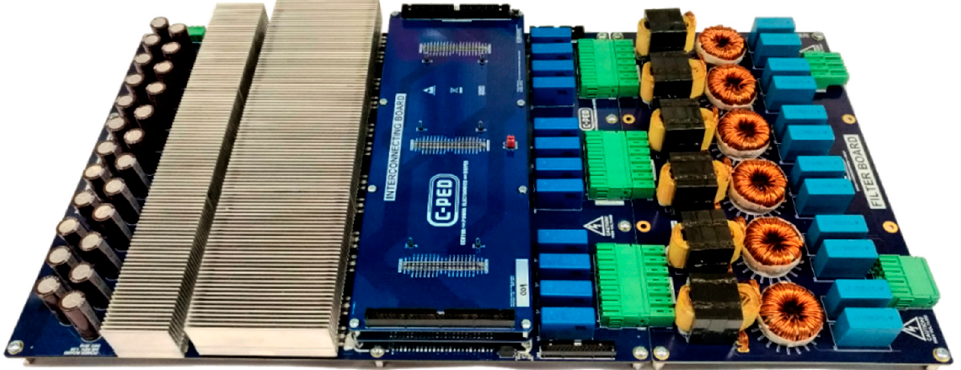
Figure 5. Charging station with integrated power electronics converters and control platforms.